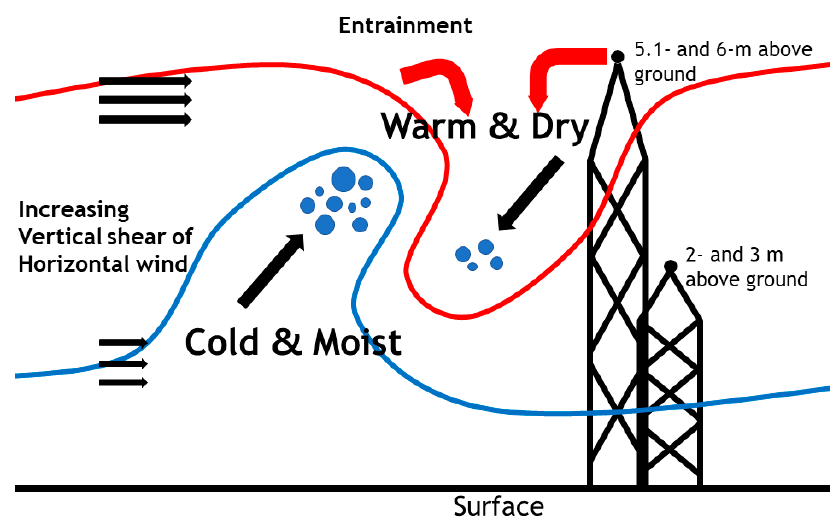
Figure 7. Schematic plot of the fog structure affected by Kelvin–Helmholtz instability (adapted from Stull, 1988 [41]).